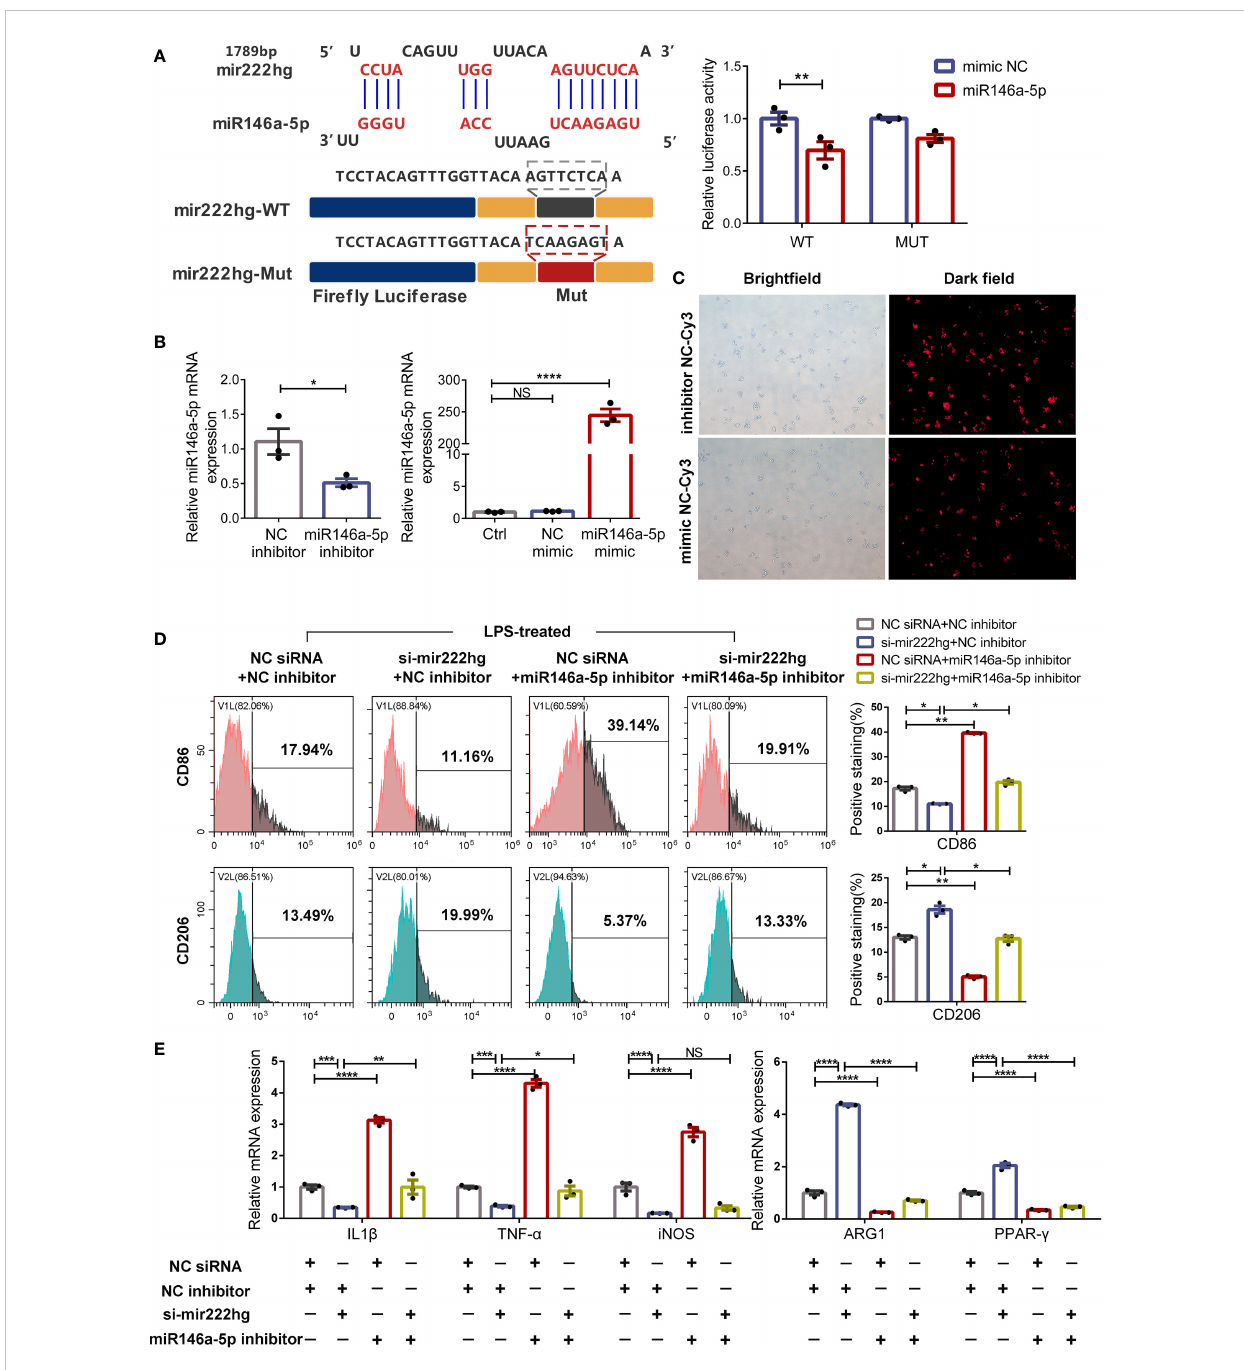
FIGURE 6 MiR146a-5p knockdown facilitates macrophage M1 polarization and reverses M2 polarization caused by silencing mir222hg (A) A schematic to show the putative mir222hg binding sites in miR146a-5p. The sequences of mir222hg-WT and mir222hg-Mut are as listed. Luciferase reporter gene assays were performed to validate the correlation between mir222hg and miR146a-5p in 293T cells. (B, C) RAW264.7 cells were transfected with NC siRNA + NC inhibitor, si-mir222hg + NC inhibitor, NC siRNA + miR146a-5p inhibitor, or si-mir222hg + miR146a-5p inhibitor, respectively. The above transfected RAW264.7 cells were then treated with 100 ng/ml LPS for 24 h. qRT-PCR assay (B) and immuno fl uorescence analysis (C) were performed to verify the transfection ef fi ciency. (D) Representative fl ow cytometry histograms (left) and statistical analysis (right) showing the surface expression of CD86 and CD206. (E) The qRT-qPCR showing IL-1 b , TNF- a , iNOS, ARG1, and PPAR- g relative mRNA expression. Each point represents data from one individual sample. Data are shown as the mean ± SEMs (n= 3 per group). Data are merged from three independent experiments. Statistical signi fi cance was assessed by unpaired t-test for experiments comparing two groups, whereas two-way ANOVA followed by Sidak ’ s multiple comparisons test was used for comparisons between more than two groups. * p< 0.05, ** p< 0.01, *** p< 0.001, **** p< 0.0001, NS no signi fi